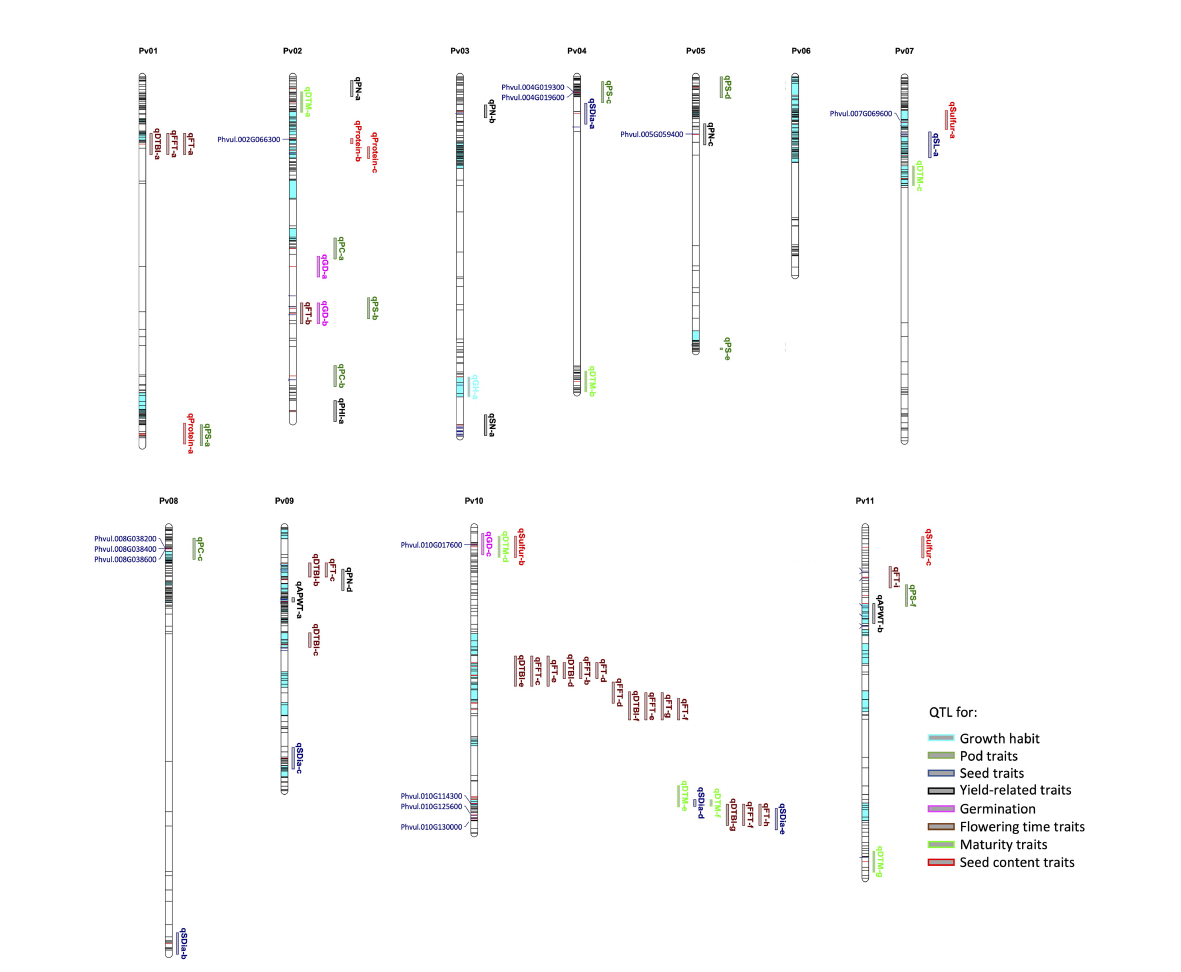
FIGURE 6 Physical map showing SNP distribution, signi fi cant markers, QTL and candidate genes identi fi ed for sixteen traits across the common bean genome. The loci in dark and red colour indicate all the SNPs used in the genotyping; the red lines indicate signi fi cant markers while the bar segments in light blue indicate haplotype blocks containing more than one SNP. The QTL and candidate genes are aligned on the right and left of the chromosomes, respectively. Refer to Supplementary Table S6 for details on QTL and candidate